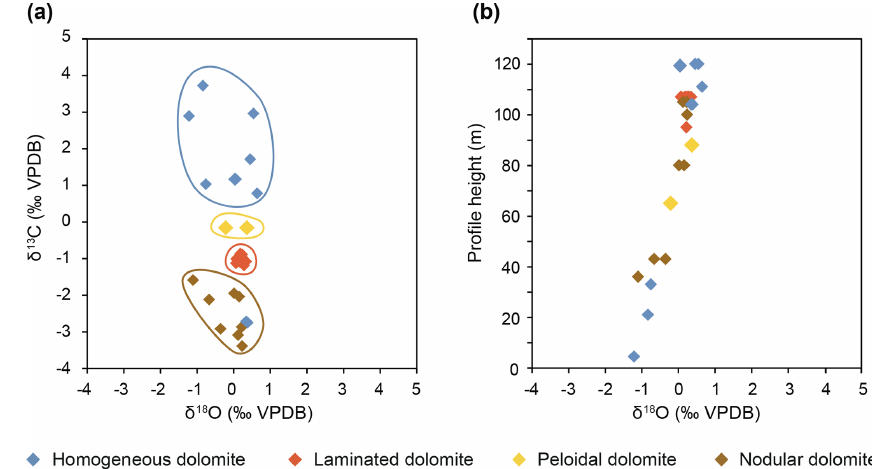
Figure 8. (a) Carbon–oxygen isotope cross plot shows a clear distinction between homogeneous, laminated, peloidal, and nodular dolomites. Nodular dolomites are probably influenced by carbon derived from organic matter. (b) Oxygen isotope values ( δ 18 O) show a positive trend with a gradient of 2‰ over the 100m thick stratigraphic section. This could be due to a decrease in precipitation temperature or to a change in the δ 18 O of the water over time.